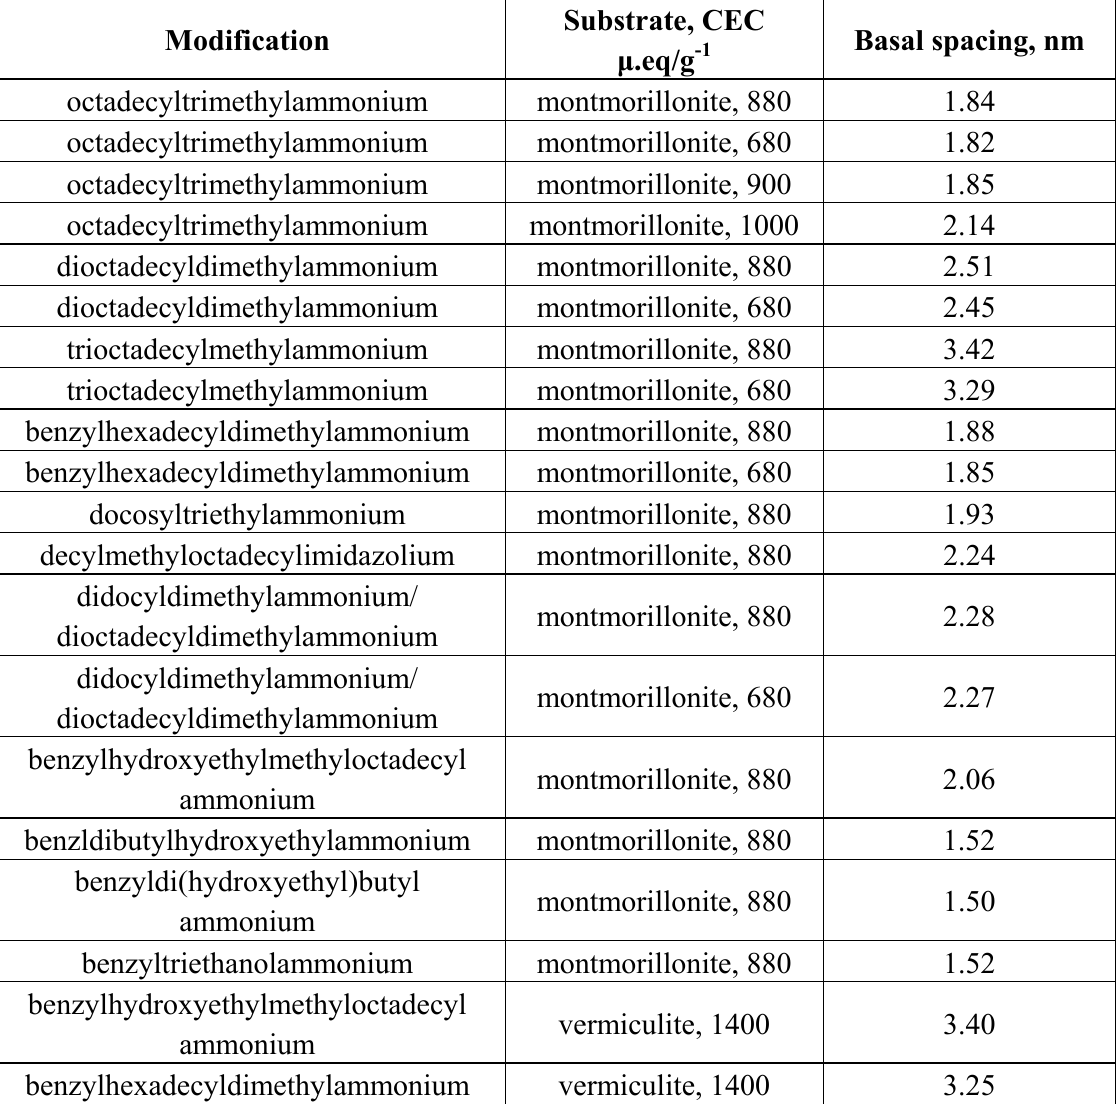
Table 1. Basal plane spacing values of various surface modified montmorillonites and vermiculites. Reproduced from reference